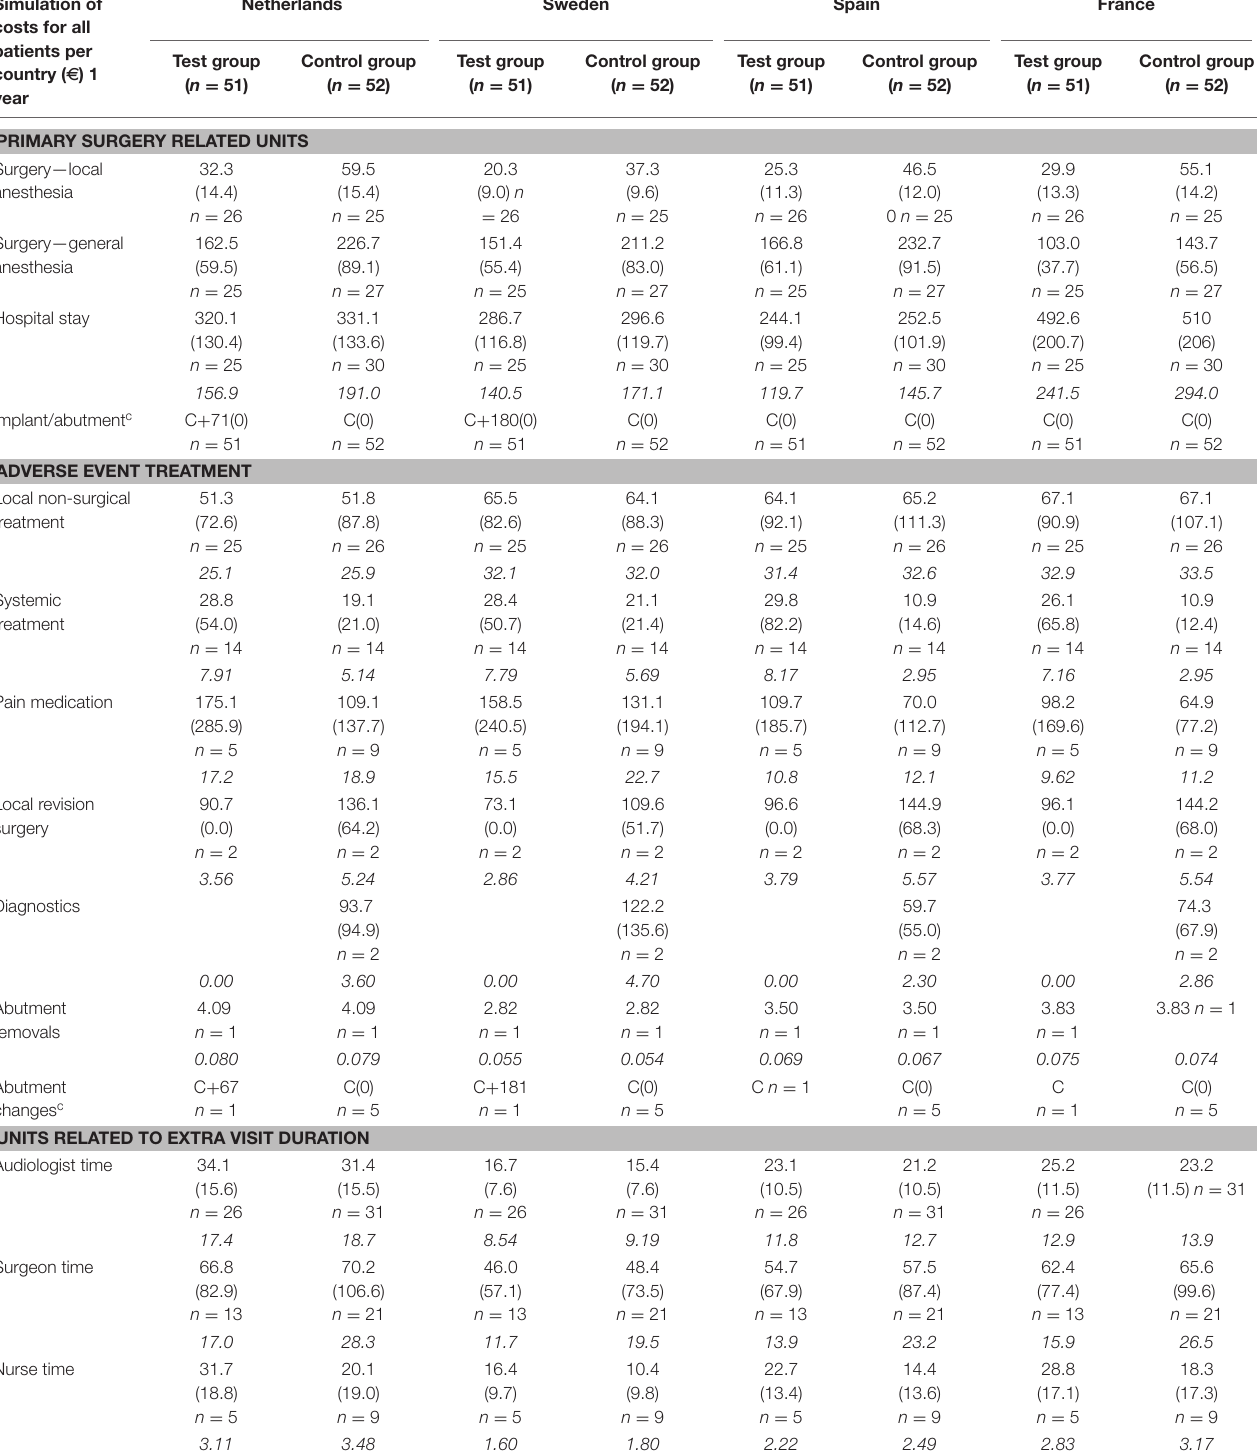
TABLE 5A | Scenario analyses: simulation of costs for all patients per country (1 year). Simulation of costs for